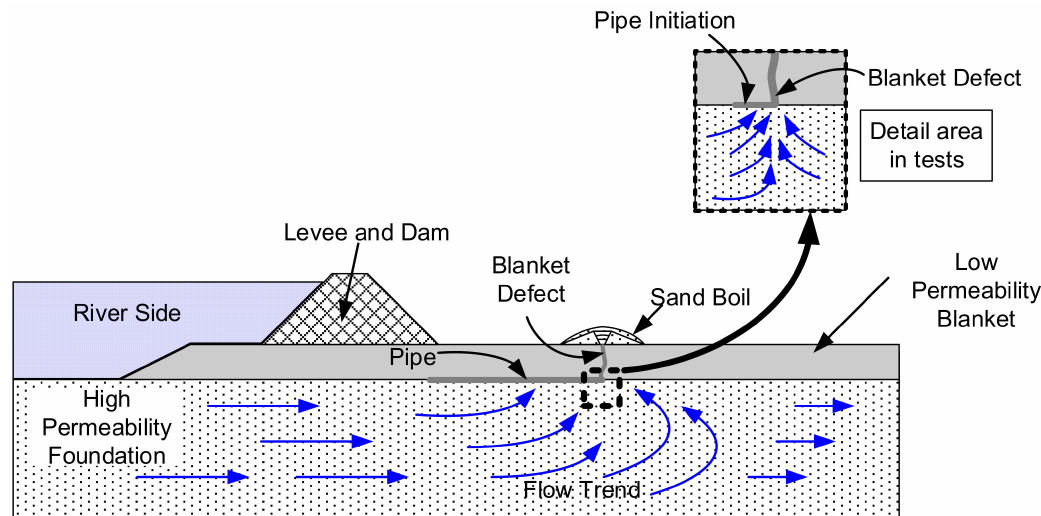
Figure 1. Schematic illustration of the BEP and the mechanisms of BEP